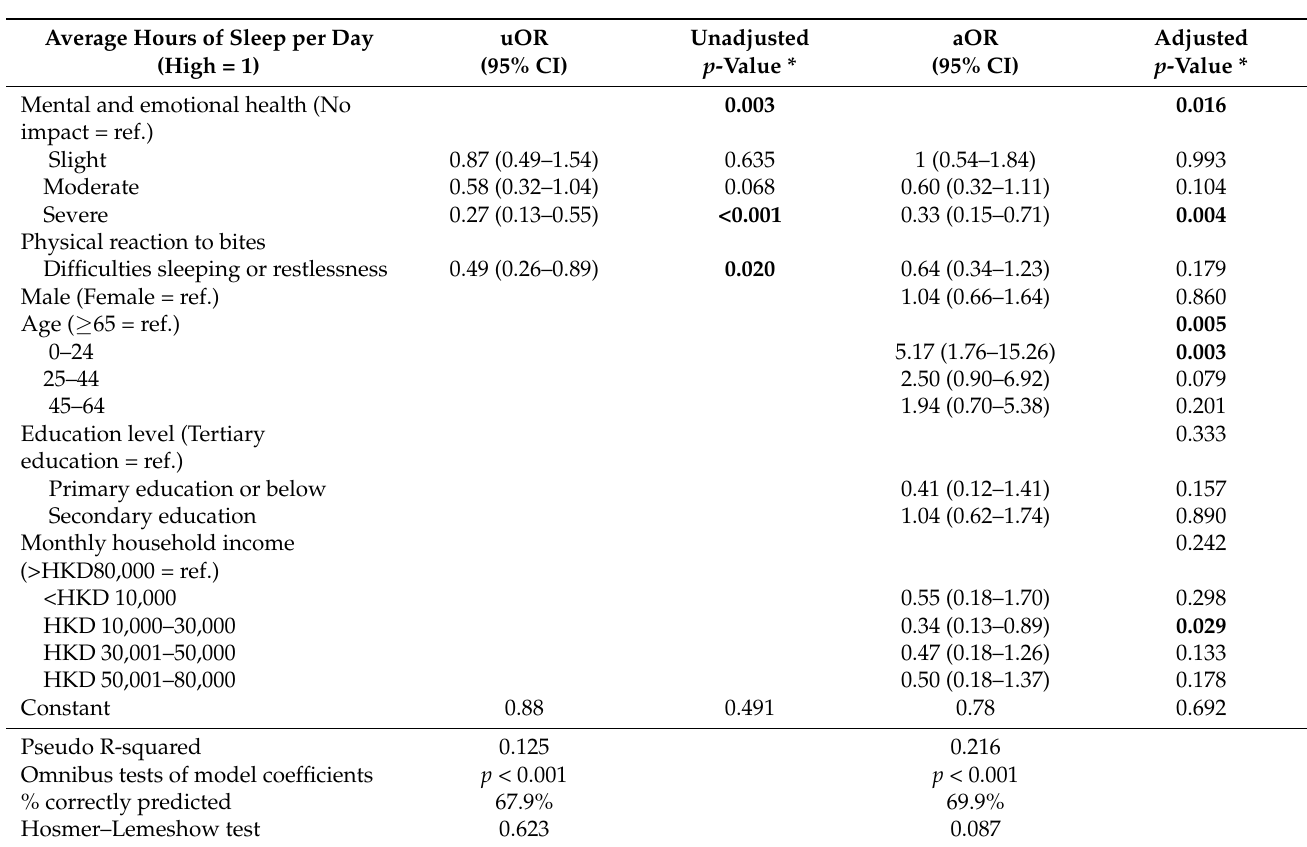
Table 4. Unadjusted and adjusted logistic regression for dichotomised average hours of sleep per day regressed against fitted